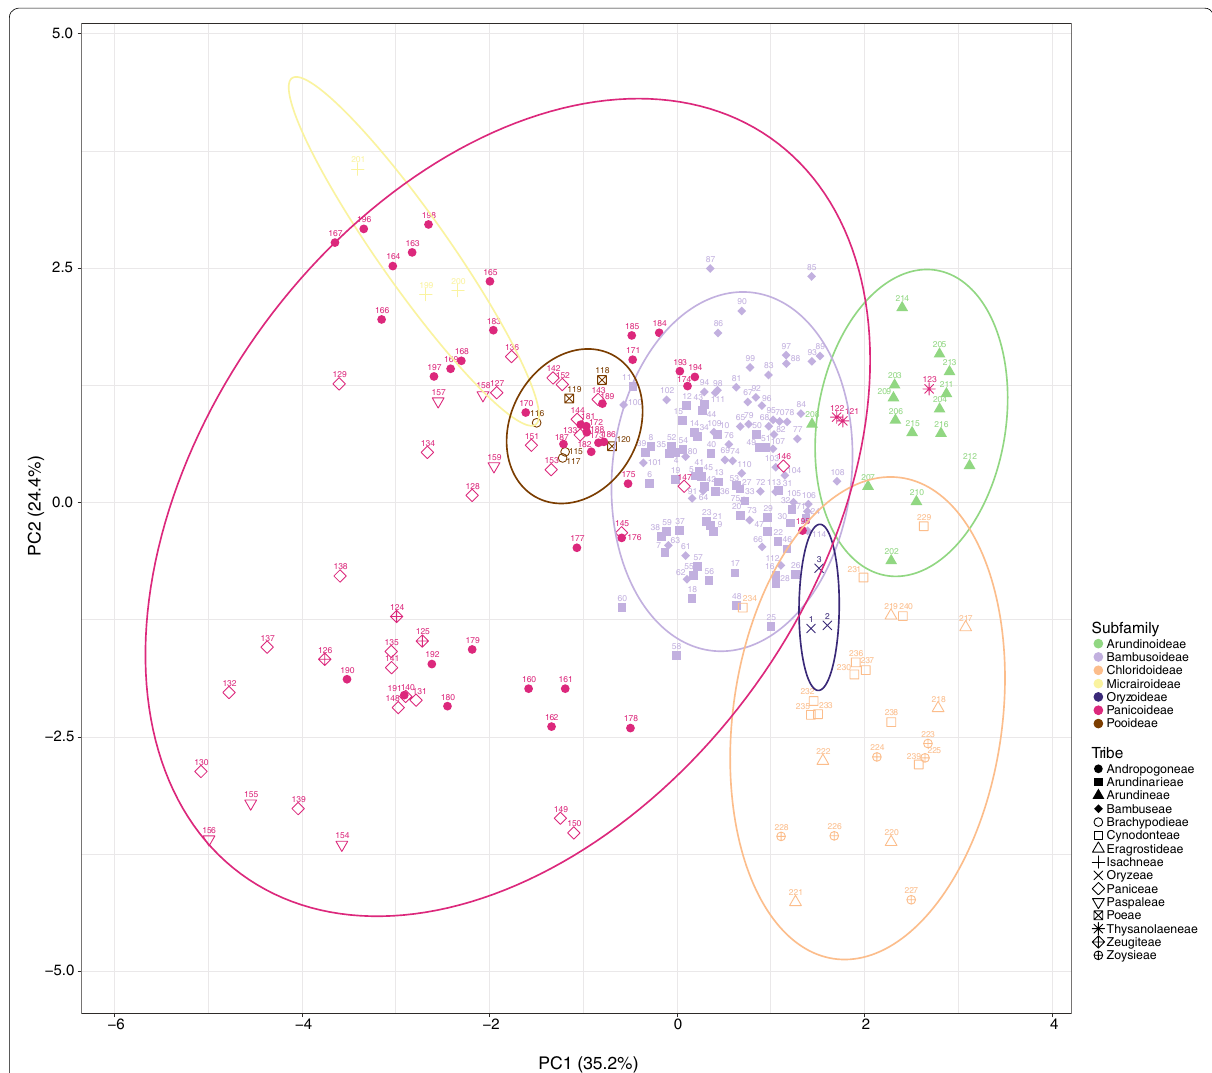
Fig. 2 PCA of Poaceae bullilform phytoliths with nine shape parameters. X and Y axis show principal component 1 and principal component 2 that explain 35.2% and 24.4% of the total variance, respectively. Prediction ellipses are such that with probability 0.95, a new observation from the same group will fall inside the ellipse. N 240. Each data point is labeled with the sample number in Table 1, Additional file 1: Appendix =